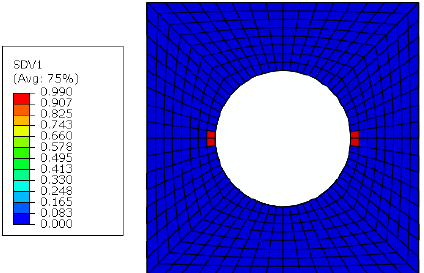
Figure 29. The initiations regions for fiber breakage based on FFNN method.